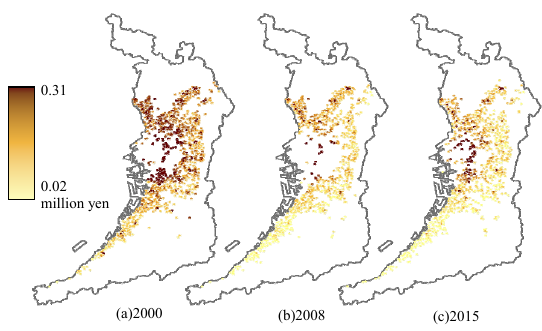
Figure 4. Distribution of land prices in SSC3